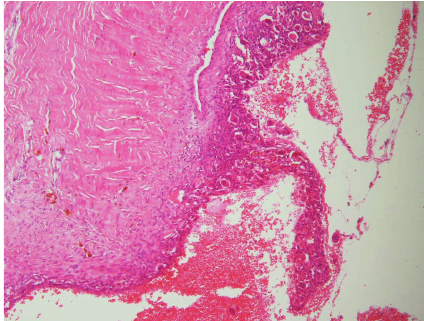
Figure 4: Histopathology (H&A, 200x) showed that the tumor cells exhibited multiple cystic lesion that was filled with red blood cells without endothelial lining surrounded by osteoclast like giant cells.